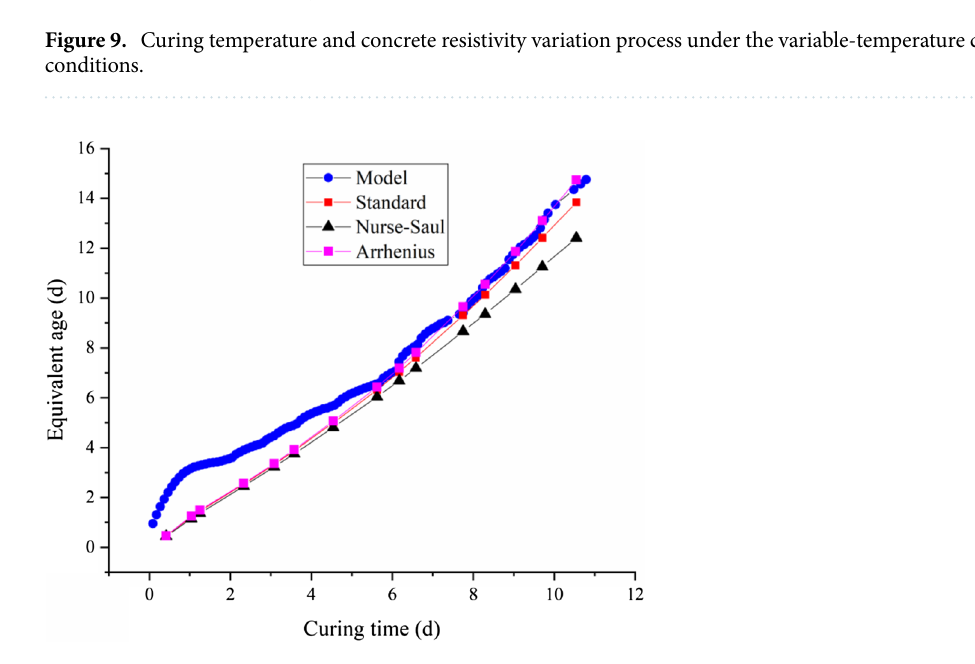
Figure 10. Comparison of the equivalent age obtained by different methods under the variable-temperature curing